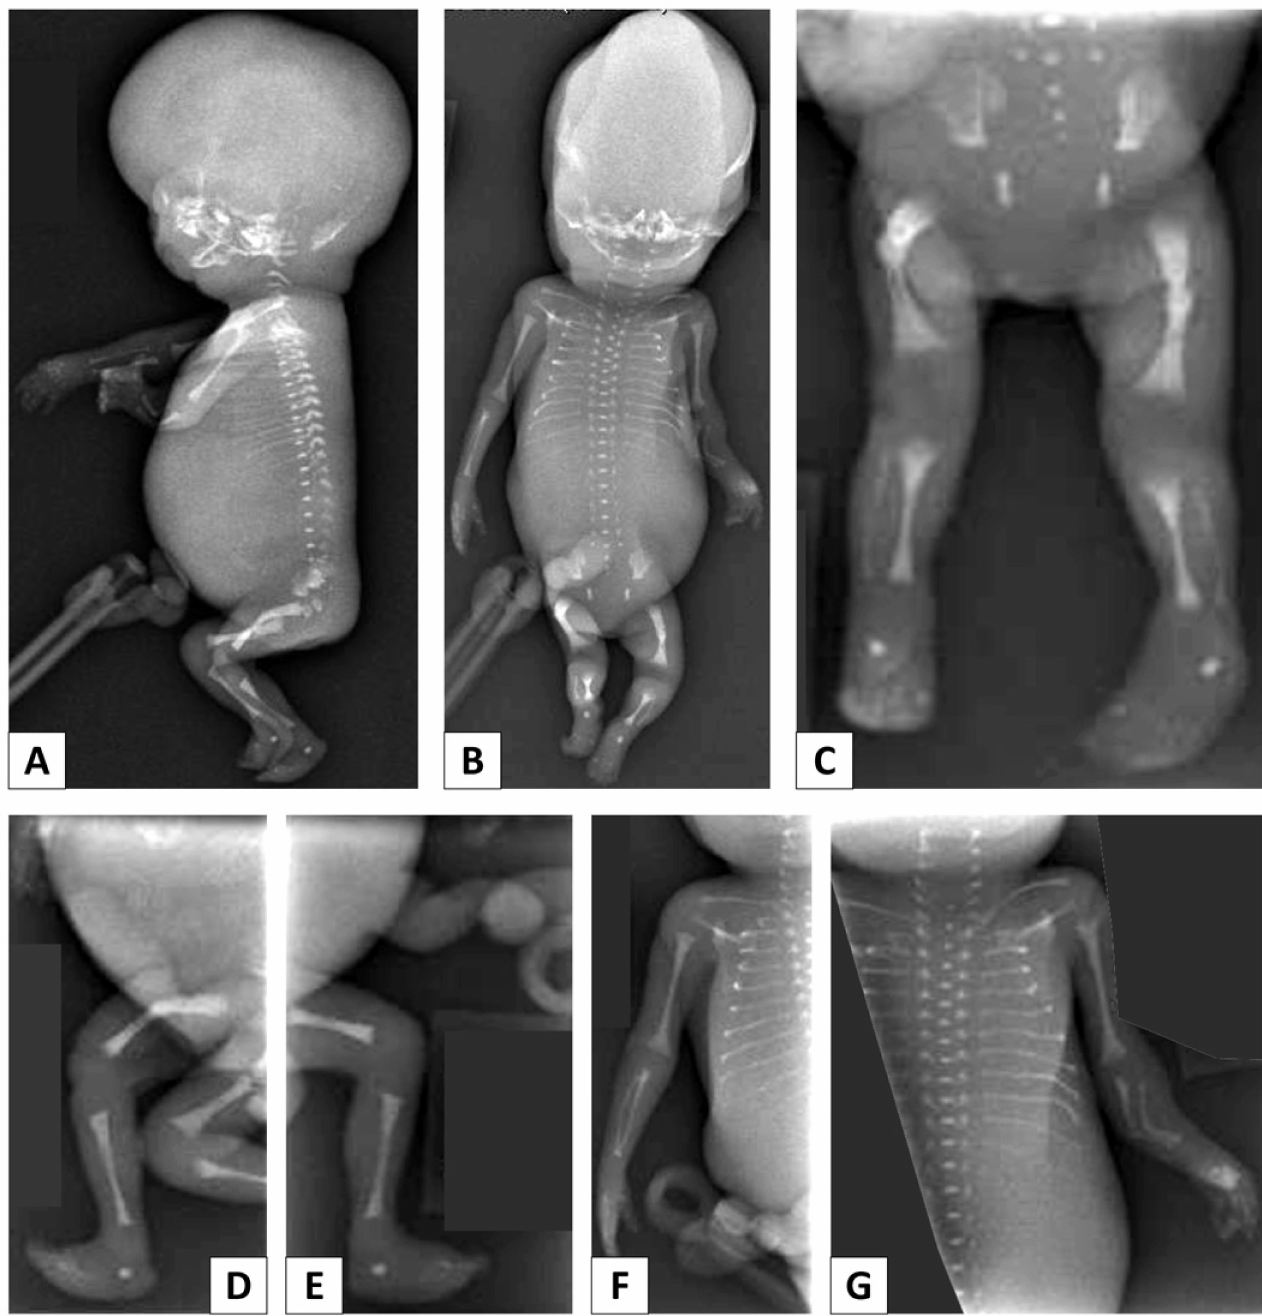
Figure 2. Clinical case #2: whole-body X-rays. ( A – E ) Reduced long bone length, thin long bones, bilateral femoral fractures with bowing. ( F , G ) Fractures with deformity of the left radius and ulna. ( A , B , F , G ) Gracile and irregular ribs, with fractures. ( C , F , G ) Bowing of the fibula and ulna. ( B – G ) Enlarged metaphyses of the tibia, femora and